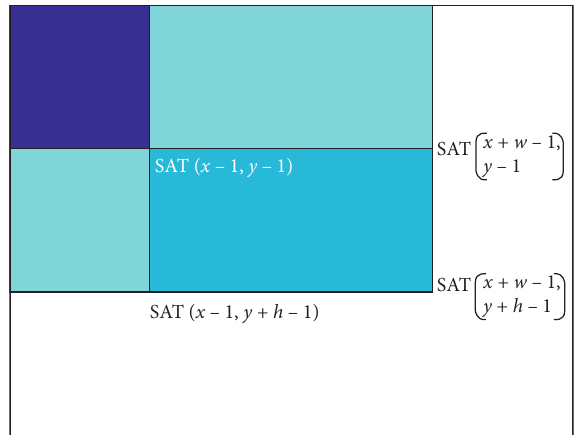
Figure 2: Area computation using integral